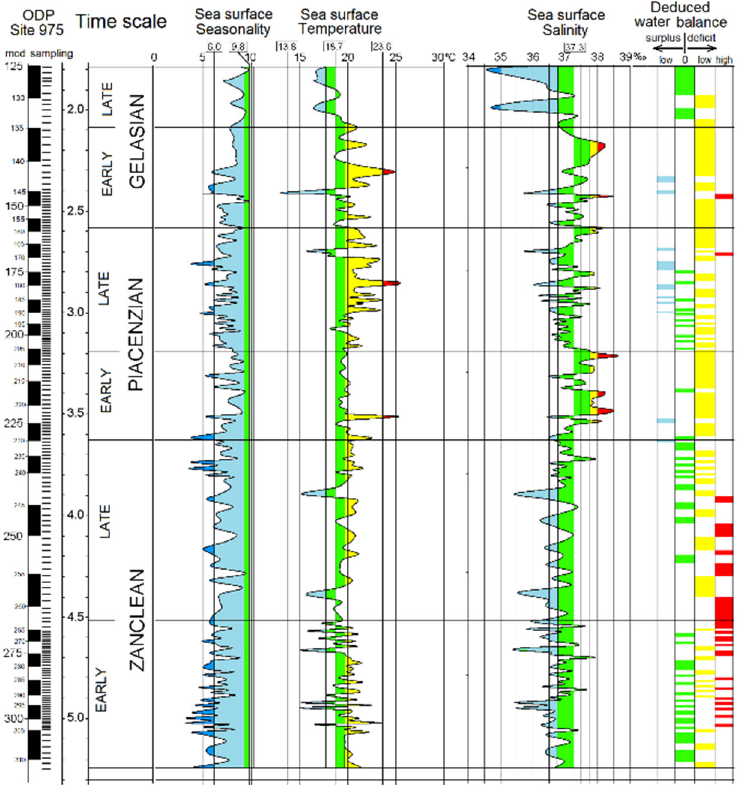
Figure 7. Variations of the paleoceanographic parameters and water balance through Pliocene– Gelasian.